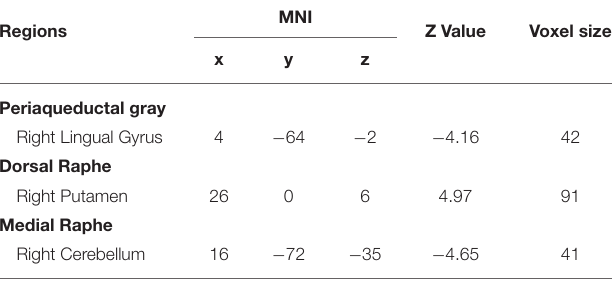
TABLE 1 | Group differences of FC between KOA and HC at post-acupuncture.